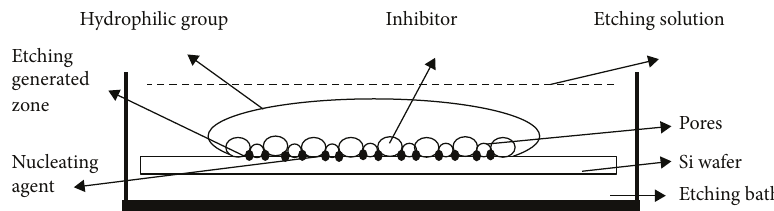
Figure 3: Schematic illustration of additive-assisted etching of the DWS-processed mc-Si wafer.